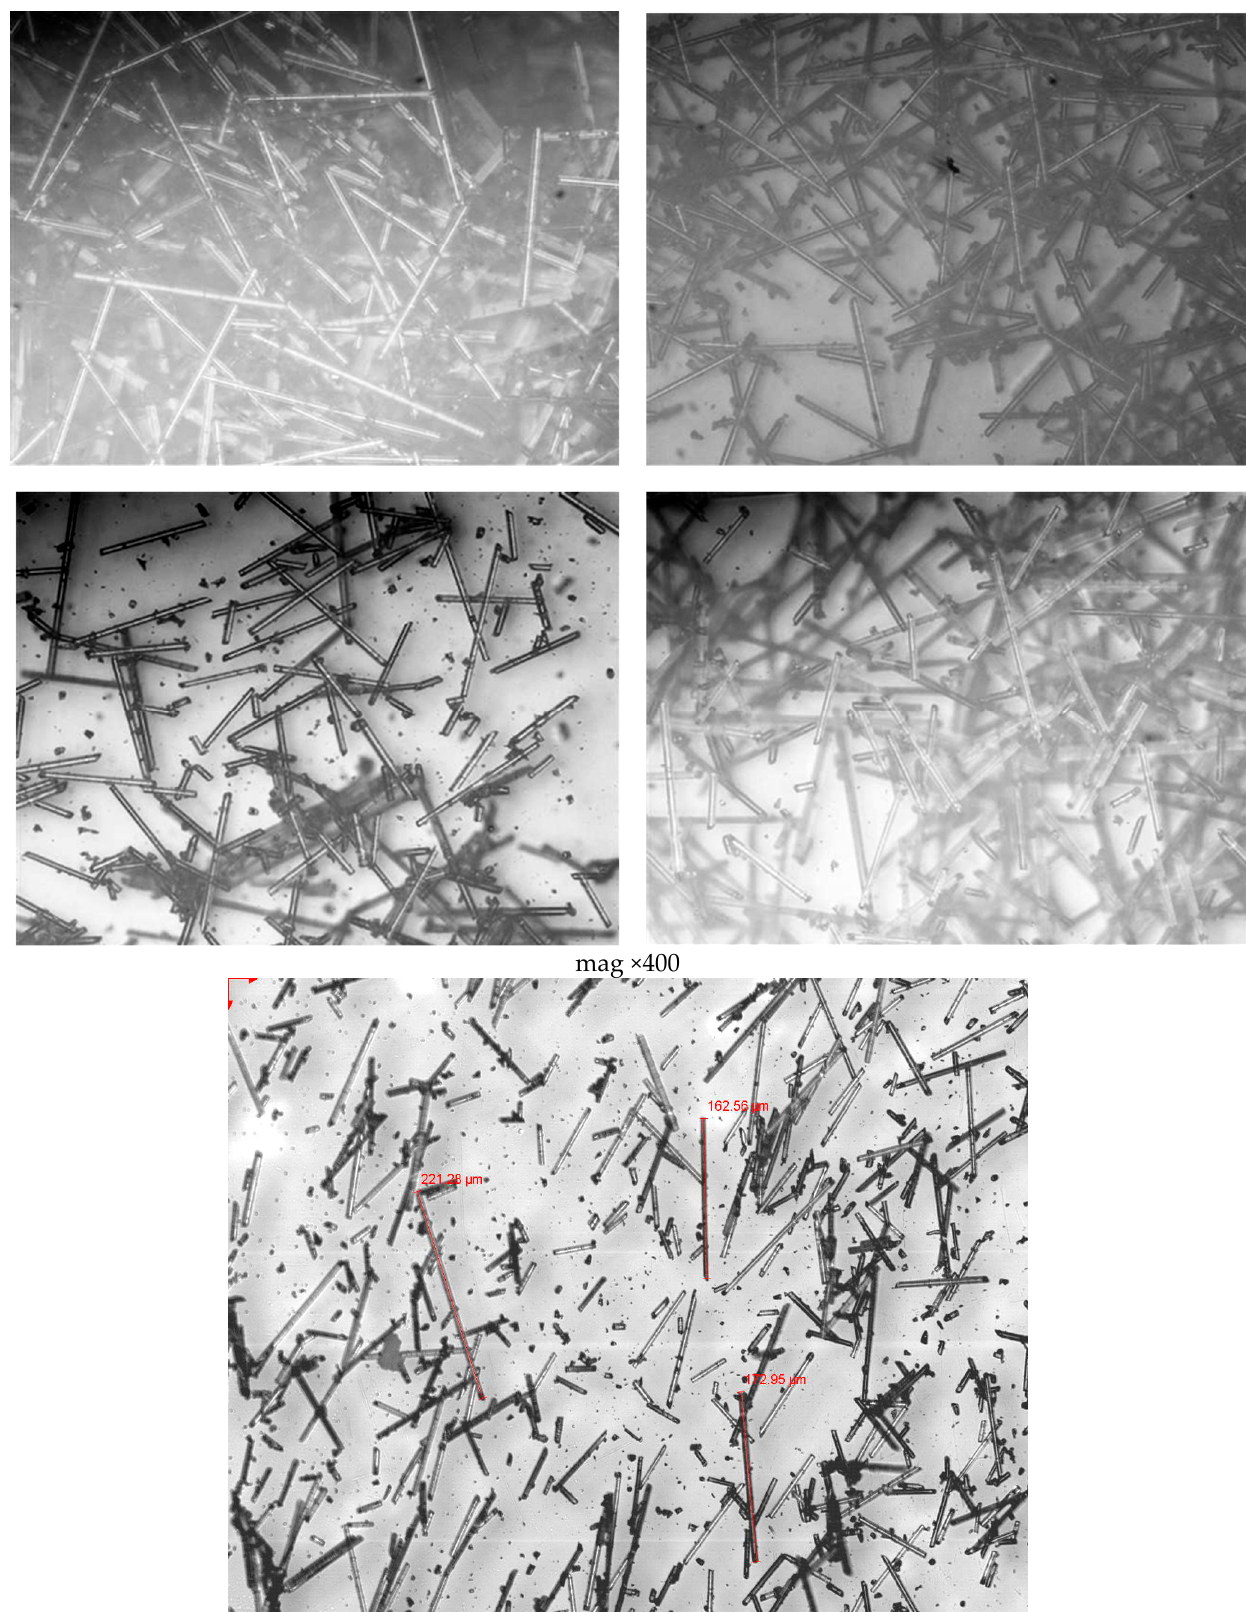
Figure 14. Optical microscope observation and measurement of fibers.